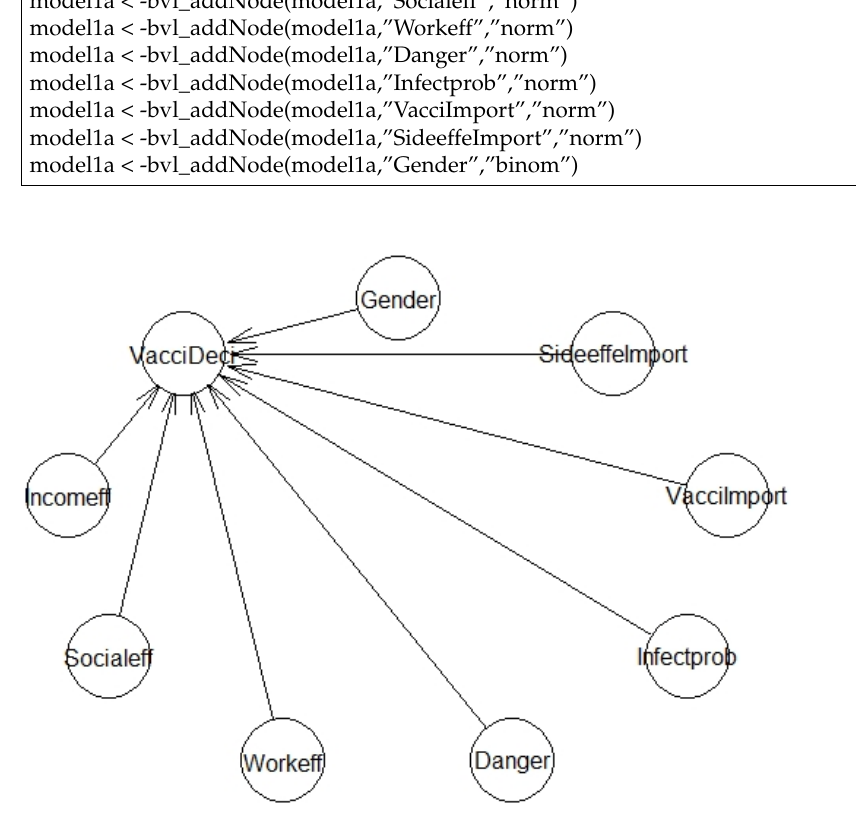
Figure 1. The model of vaccination decision